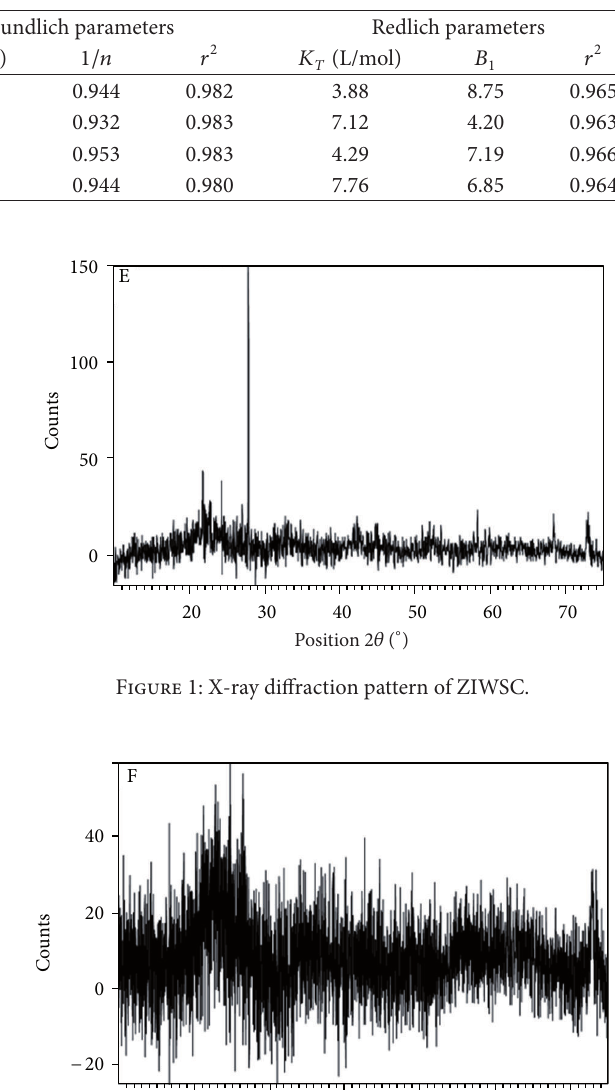
T 1: Linear isotherm parameters of �uoride adsorption on ZIWSC.